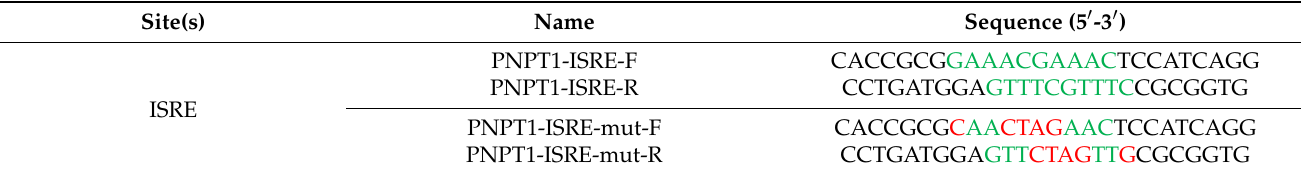
Table 2. Oligonucleotides used in EMSA. Motifs are shown in green and mutations in red.